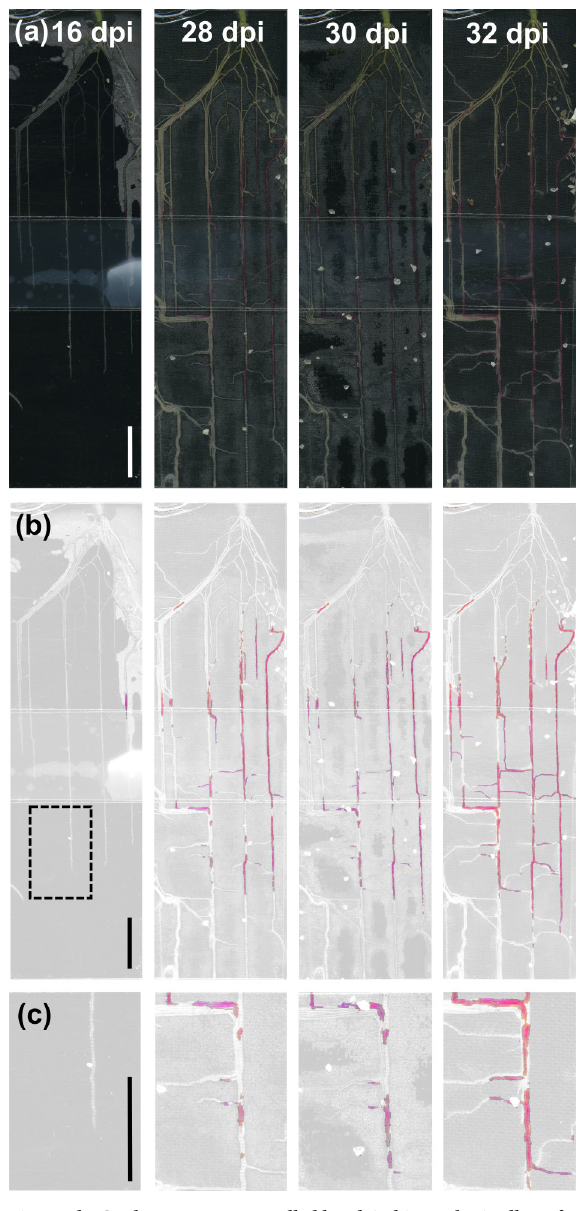
Fig 8. NbBCP1b promoter-controlled betalain biosynthesis allows for dynamic tracing of root colonisation processes in Nicotiana benthamiana . Transgenic NbBCP1 -p3 plants grown in a rhizotron setup supplied with Rhizophagus irregularis spore inoculum imaged over time. (a) Reflective light images, (b) represent the same images filtered for red/magenta hues, and (c) is a magnification of the area delimited by the dashed square over time. Scale bar, 1 cm. dpi, days